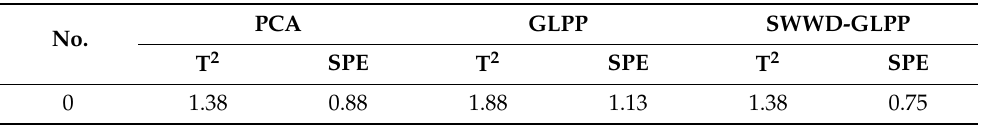
Figure 7. ( a ) Monitoring charts of PCA for normal data. ( b ) Monitoring charts of GLPP for normal data. ( c ) Monitoring charts of SWWD-GLPP for normal data. Table 2. False alarm rates of normal data (%).